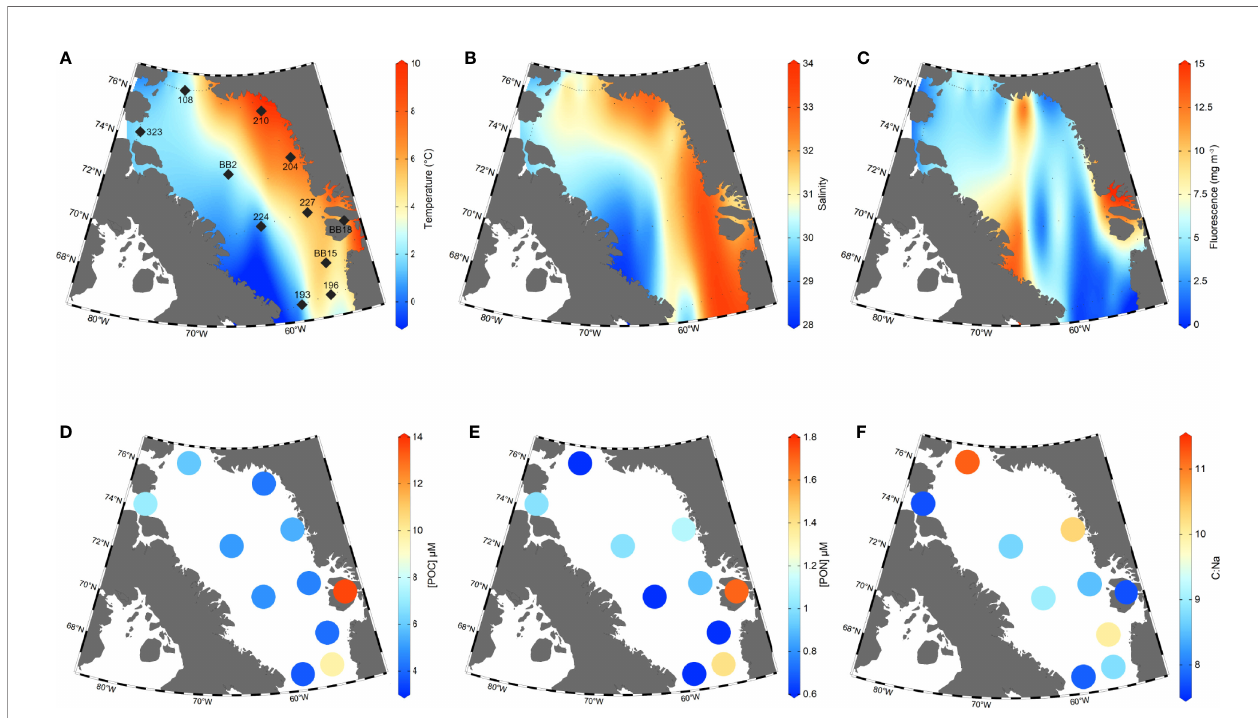
FIGURE 2 | Station map together with sea surface temperature, salinity, fl uorescence, [POC], [PON], and C:N. Plots (A – C) : Data from all stations visited in the 2019 research cruise were used to create the interpolated surface distributions of sea surface temperature ( A ; SST), salinity (B) and fl uorescence at the deep chlorophyll maximum (C) . Here, SSTs are CTD temperatures from 2-3 metres depth (°C), sea surface salinities are CTD data from 2-3 metres depth and reported in Practical Salinity Units (PSU), and fl uorescence values are for the deep chlorophyll- a maximum depth (30-40m). Stations from which POM samples were collected are indicated by large black diamonds on Plot (A) All other cruise stations in which CTD data was collected (such as temperature, salinity, and fl uorescence) are indicated by small black dots. Plots (D – F) show [POC], [PON] concentrations in µmol L -1 and C:N a ratios from each